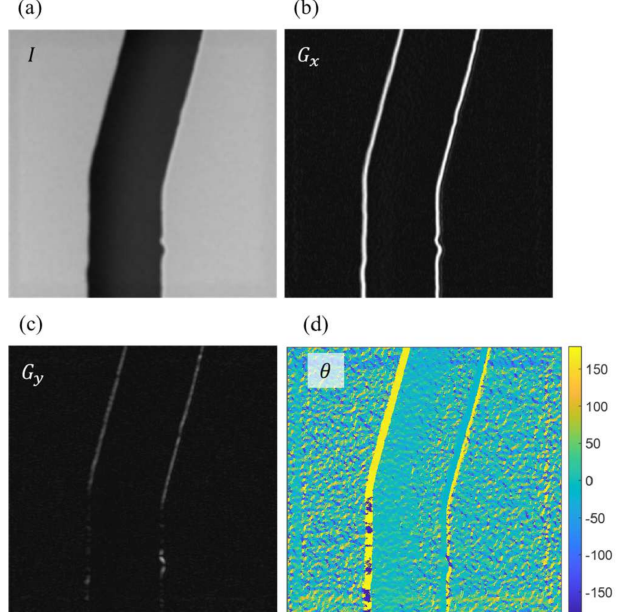
Figure 9. The directions perpendicular to the edge points are determined using Sobel operators. ( a ) Original image taken from the SEM. ( b ) The intensity gradients in the horizontal direction. ( c ) The intensity gradients in the vertical direction. ( d ) The directions of intensity gradients in